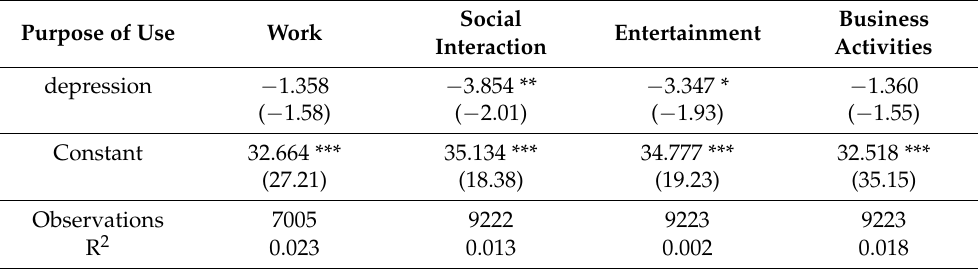
Table 9. Heterogeneous effects 3.